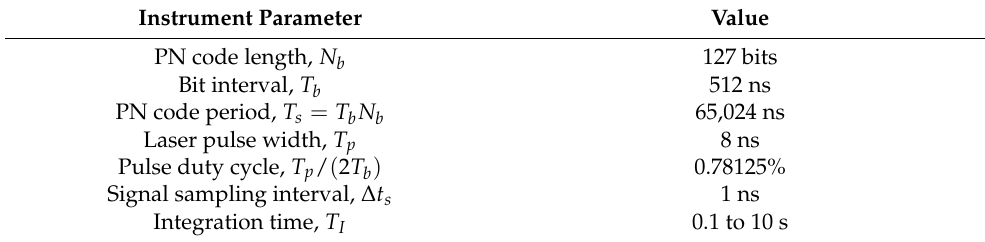
Table 4. RZPN code used in